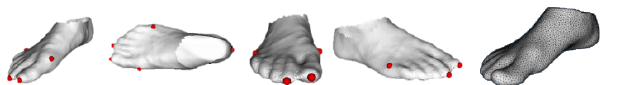
Figure 9. Foot landmarks used for registration in the database and foot template topology (the last image).